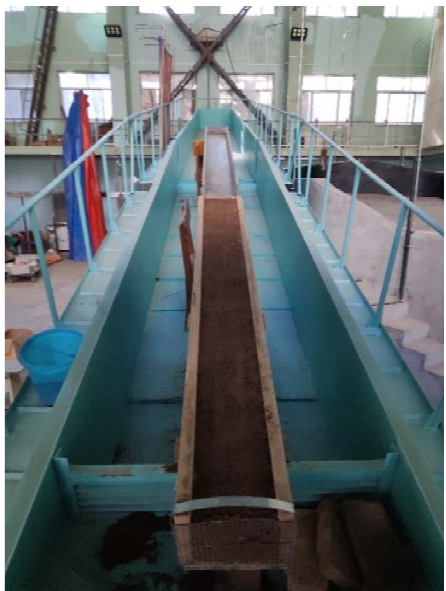
Figure 2. Photograph of the scouring experiment model.